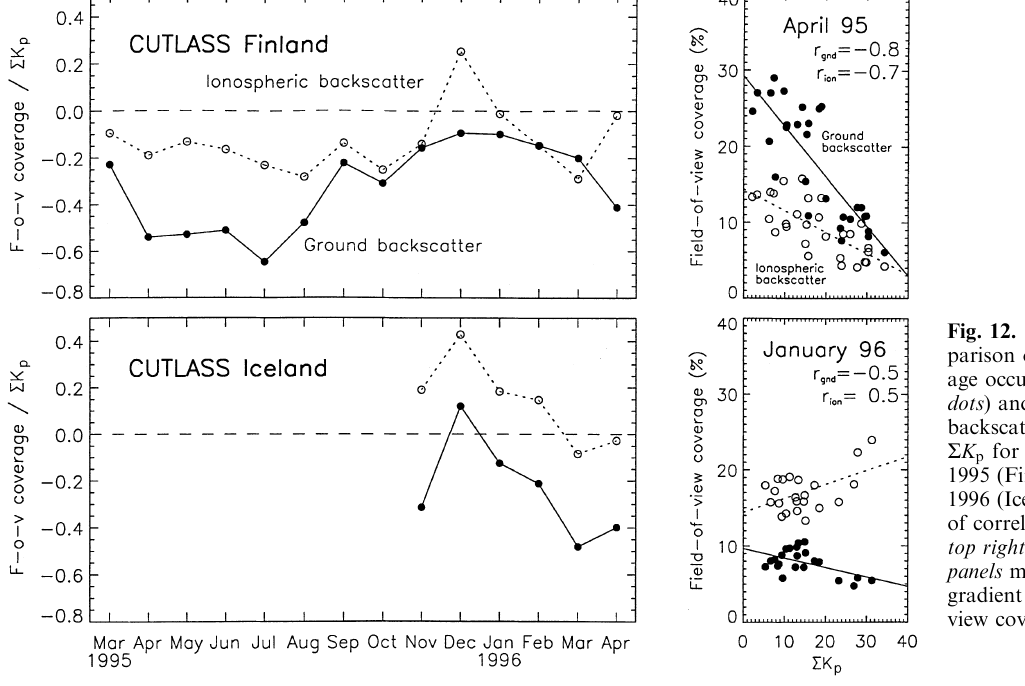
Fig. 12. right-hand panels A com- parison of the mean daily percent- age occurrence of ground ( filled dots ) and ionospheric ( open dots ) backscatter with the daily value of (cid:82) K p for the typical months April 1995 (Finland radar) and January 1996 (Iceland radar). Coe(cid:129)cients of correlation are indicated in the top right-hand corners . left-hand panels monthly variation of the gradient of the fit between field-of- view coverage and (cid:82) K